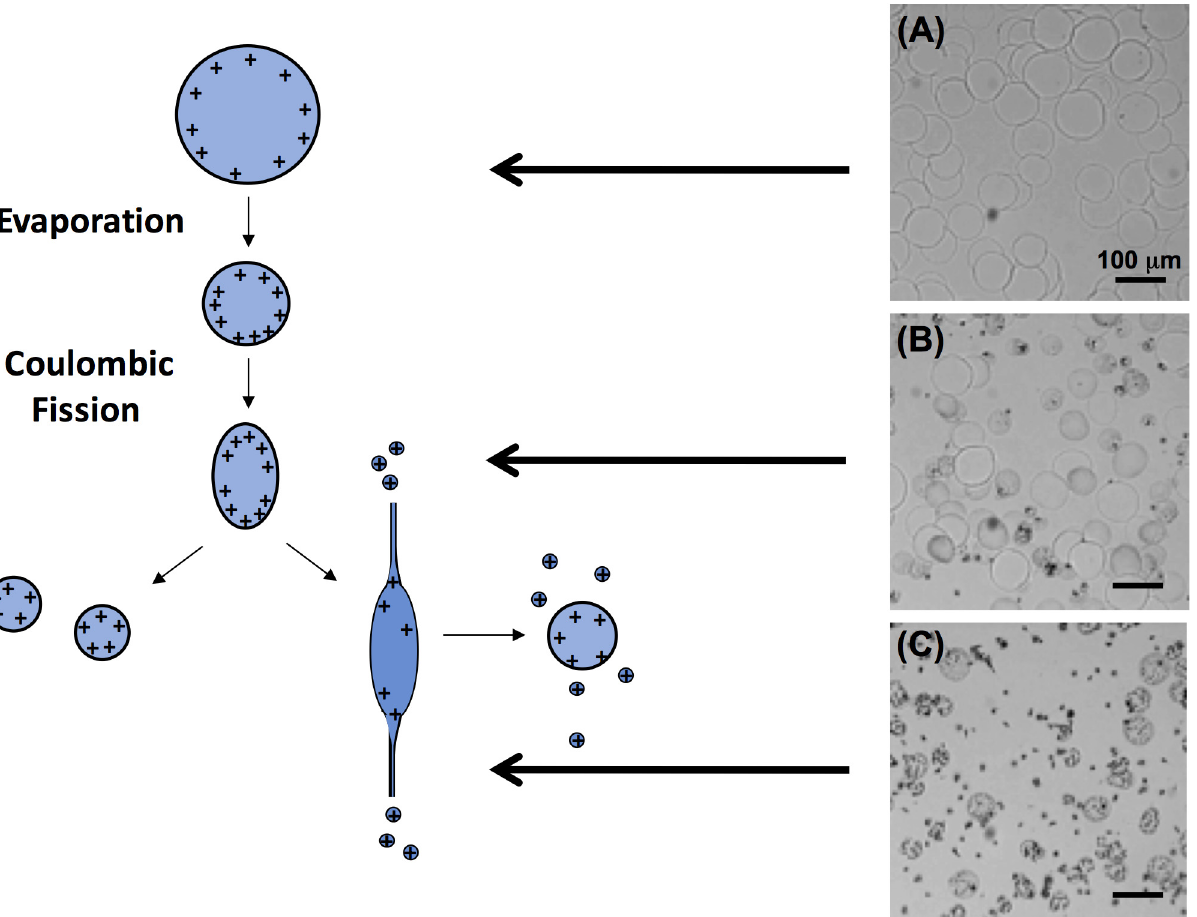
Fig 4. Breakup of electrosprayed droplets due to Coulombic fission. Schematic (left) and optical microscopy (right) images of deposited droplets collected from electrspraying mist at different tip-to-collector distance of (A) 3 cm, (B) 6 cm and (C) 9 cm, using a same scale bar of 200 μ m. Fragmented droplets were formed in (B) and (C) due to Coulombic fission. The electrospraying process was performed using a constant tip-to-plate distance of 9